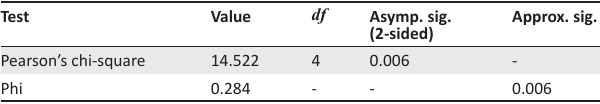
TABLE 6: Stepladder technique versus perceived decision-making success.